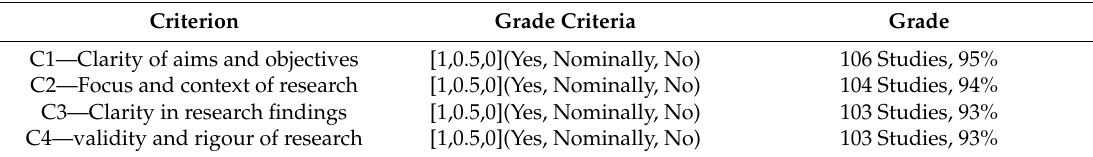
Table 1. Criteria for assessment of